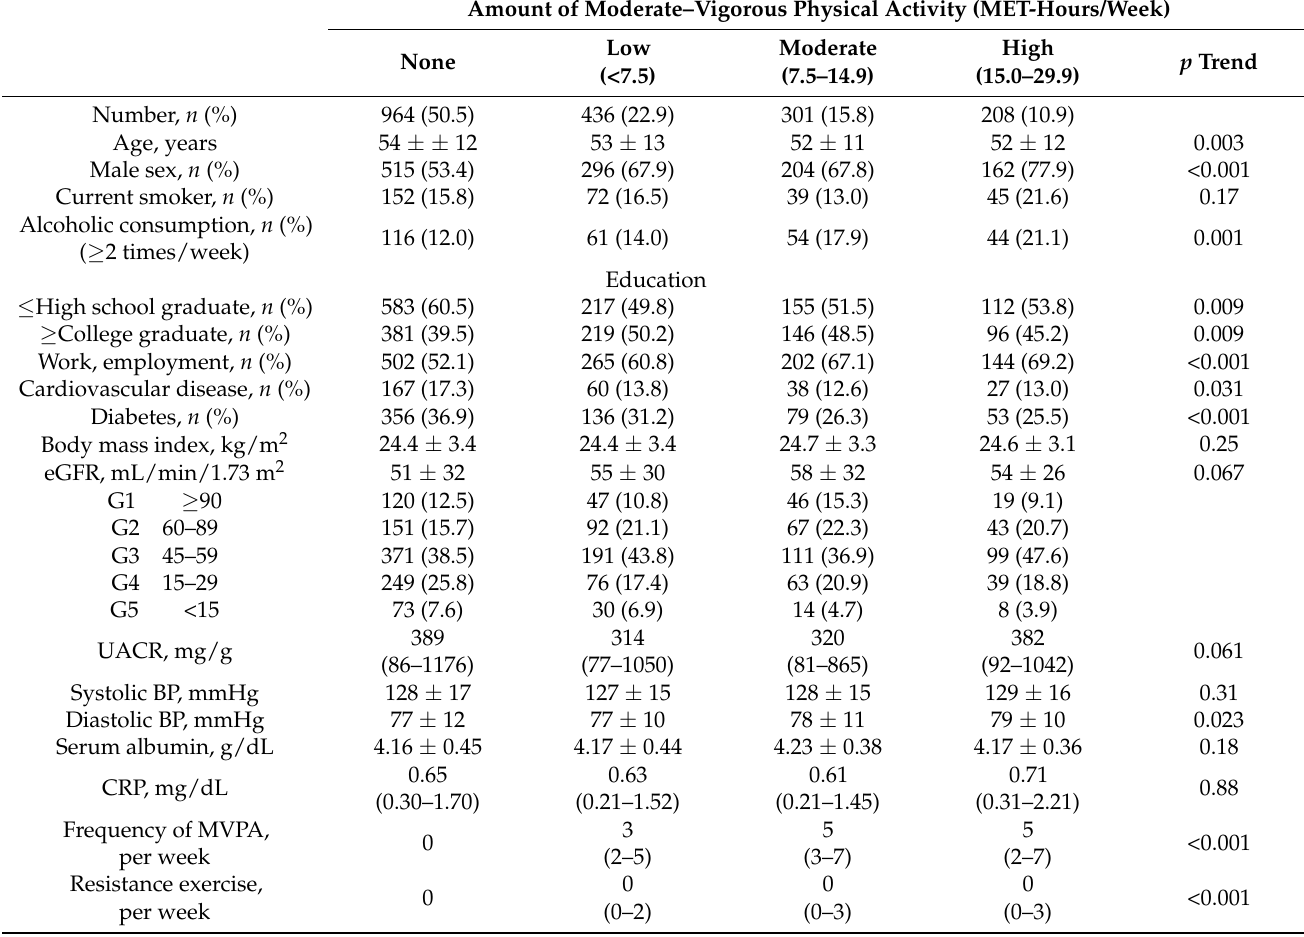
Table 1. Baseline characteristics of the 1909 adults with nondialysis CKD according to the amount of MVPA. Amount of Moderate–Vigorous Physical Activity (MET-Hours/Week) None